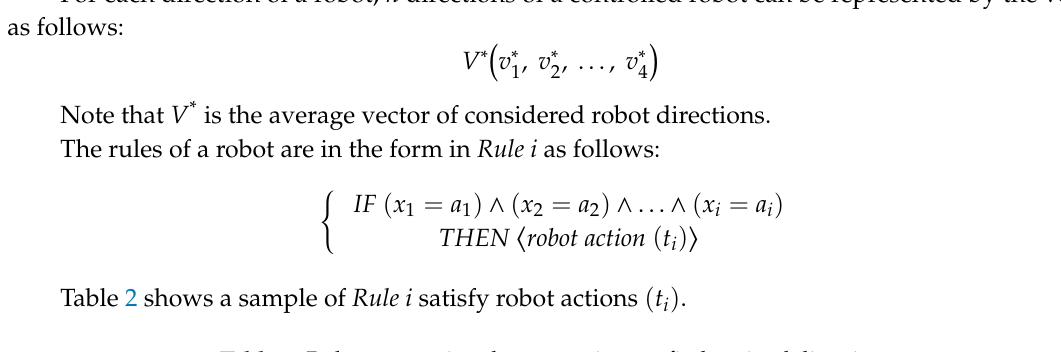
Table 2. Rules present in robot reasonings to find optimal